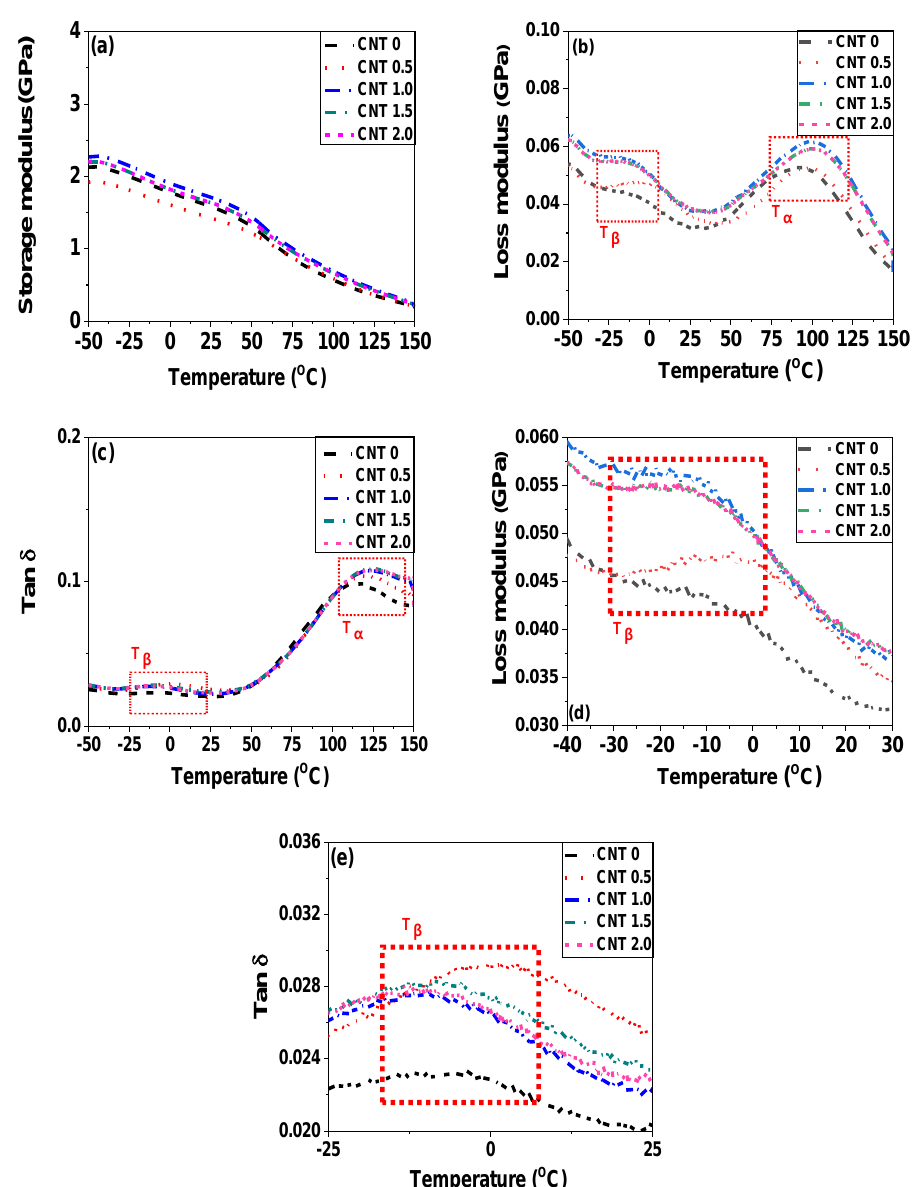
Figure 5. DMA data of POM/CNT nanocomposites: ( a ) storage modulus; ( b , d ) loss modulus; ( c , e ) tan δ ; ( d ) zoomed in area of Figure 5b; ( e ) zoomed in area of Figure 5c.